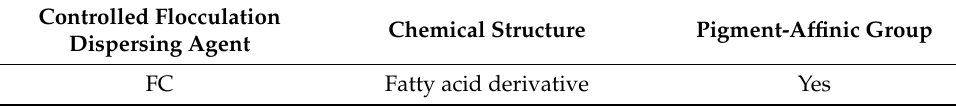
Table 4. Chemical nature of the controlled flocculation-based dispersing agent. Controlled